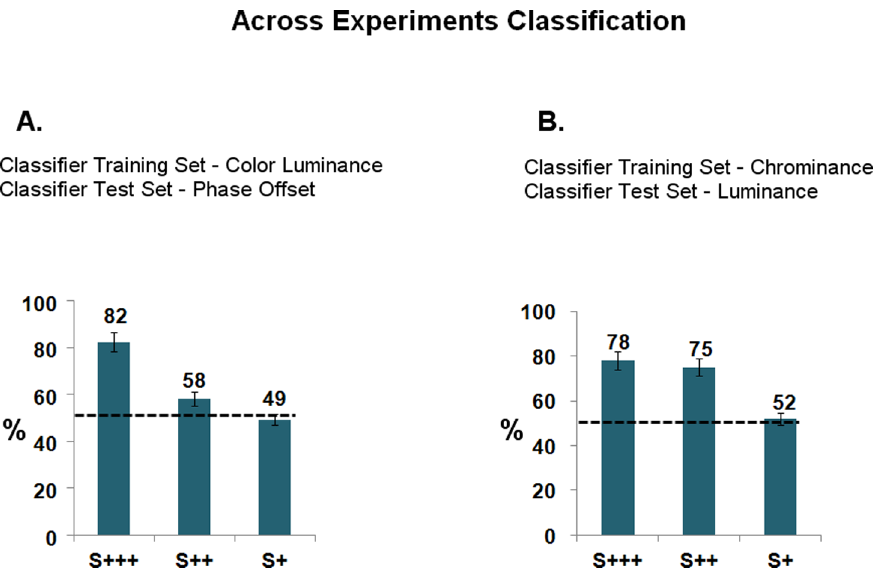
Figure 8. Classification Results Across Experiments, in Balanced Accuracy Performance Measures: classification accuracy is proportional to saliency levels. A. Classification model fot target detection built from the Color Luminance experiment and used to classify Phase Offset experiment events’. B. Classification modelfor target detection built from the Chrominance experiment and used to classify Luminance experiment events’. Dashed lines depict chance level at 50%. Bars depict confidence intervals for the means at 95%.